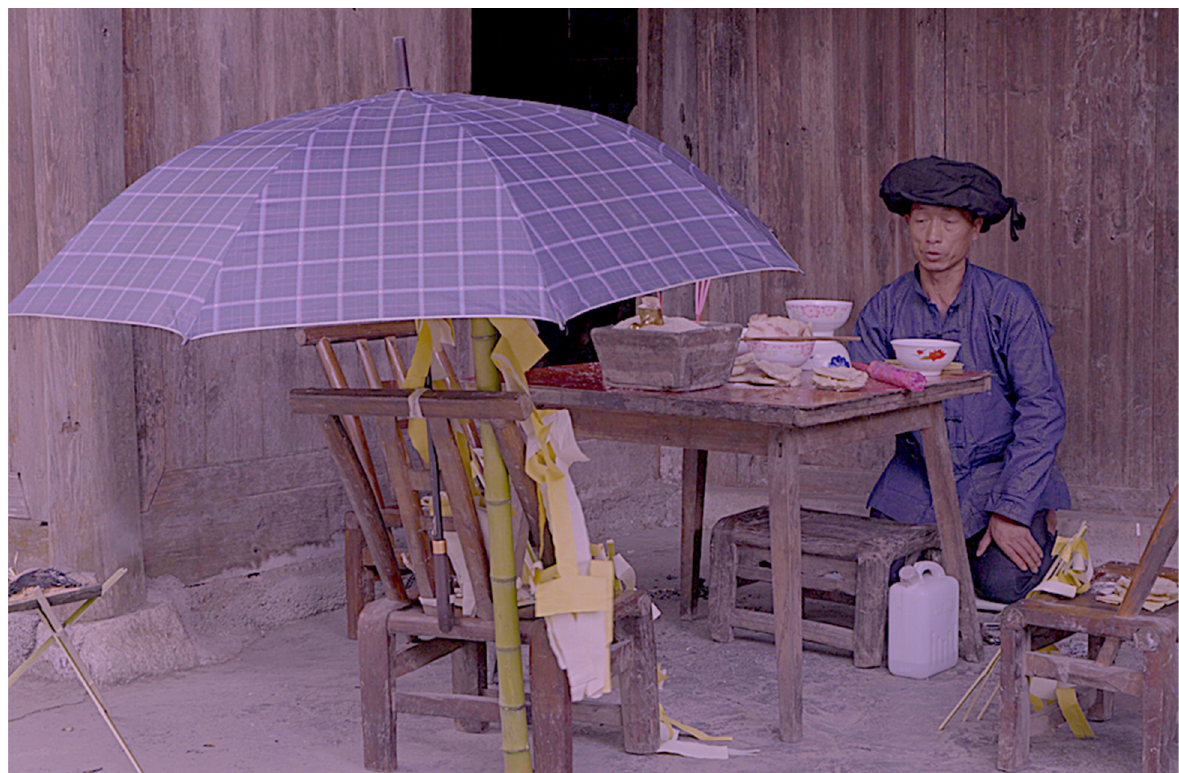
Figure 13. Badai Yang at the altar for the three brothers. (Photo: Thomas Riccio). The narrative, in another variation of telling demonstrates its mailability: In ancient times there were three brothers who were loyal generals of the